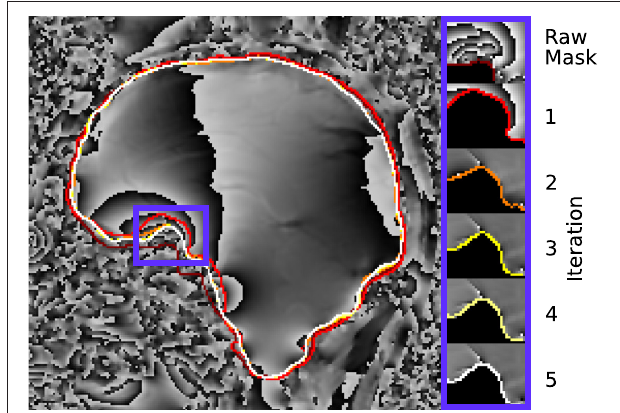
FIGURE 10 | Illustration of the evaluation mask for conventional (raw) processing and REFRASE analysis on the measurement data (sagittal slice). The purple frame indicates the masked region shown on the right-hand side. For REFRASE, a threshold of Q LC,min = 0.6 was chosen. Each coloured rim indicates the iteration step, shown in masked view on the right-hand side. The phase of the second echo is shown in the background.